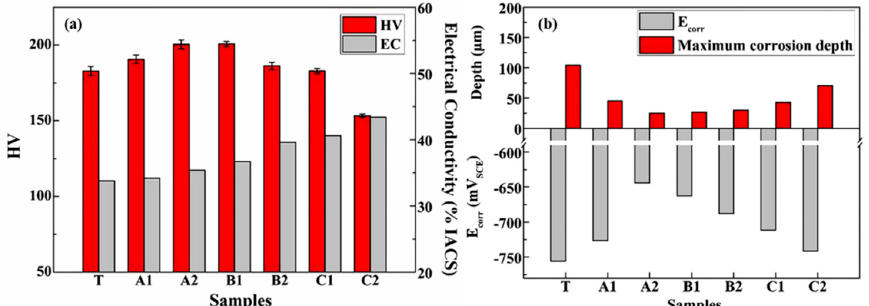
Figure 22. ( a ) Hardness and conductivity of 7085 alloy with different aging conditions; ( b ) Effect of retrogression treatment on the values of Ecorr and maximum corrosion depth in IGC test. (Reprinted with permission from ref. [36]. Copyright 2020 Elsevier).